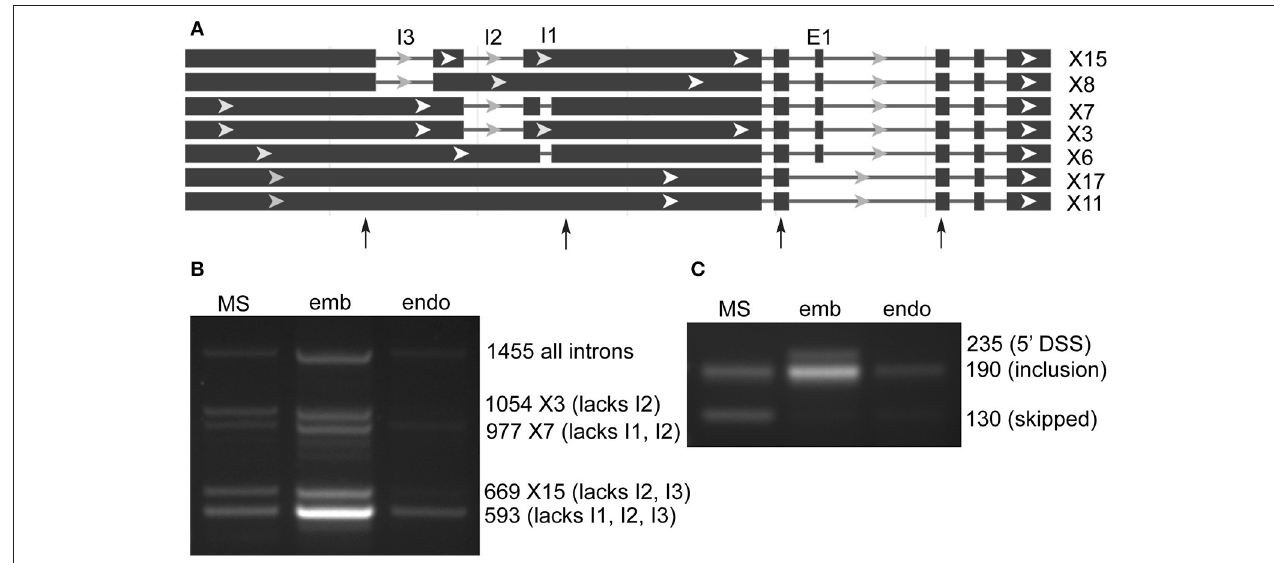
FIGURE 3 | Alternative splicing of ncRNA LOC9270896 skipped exons and retained introns in milk seed, embryo, and endosperm. (A) Gene structure. Primers flanking skipped exons and retained introns are indicated by arrows. (B) RT-PCR analysis of retained intron amplicons (MS, milk seed; emb, embryo; endo, endosperm). The 1,455 bp band containing all three introns is present in 15 of 20 predicted variants, whereas the 593 bp band from which all introns are spliced out is not predicted but predominates in embryo. (C) Exon skipping is seen in milk seed. In embryo exon retention and an unannotated differential 5 ′ splice site variant are